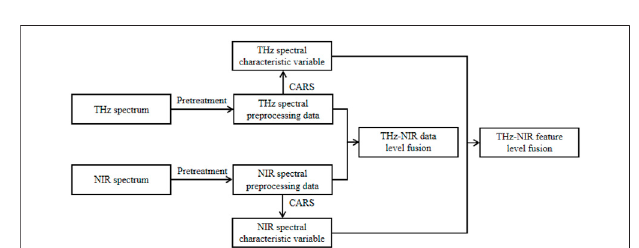
FIGURE 3 | THz spectrum acquisition.